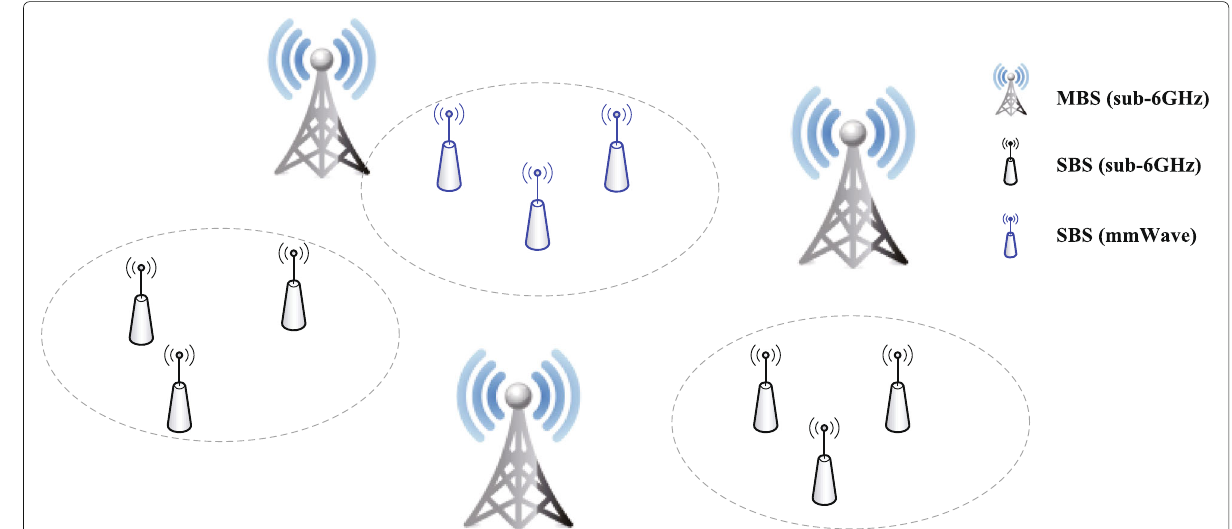
Fig. 1 System model for mmWave cellular